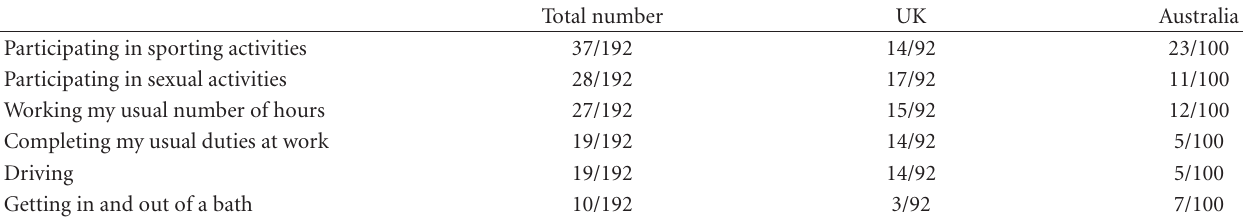
Table 3: Applicability of the questions in the TESS by country. Most common questions listed as “not applicable” by respondents. Results given as the total questions answered as “not applicable”/total number of